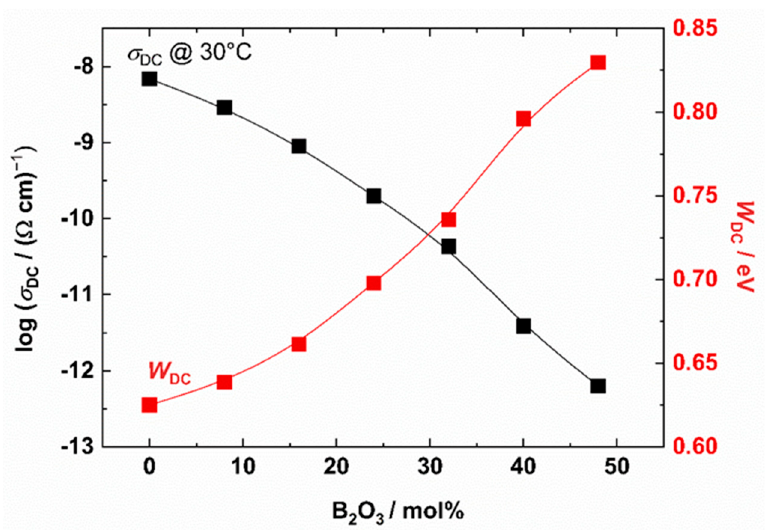
Figure 9. DC conductivity at 30 °C (black line) and activation energy for DC conductivity (red line) as a function of B 2 O 3 content for (100 − x)[0.4P 2 O 5 –0.2Nb 2 O 5 –0.4P 2 O 5 ]-xB 2 O 3 , 0 ≤ x ≤ 48 mol%, glasses. The lines are drawn as guides for the eye. Table 3. The number density of sodium ions, N, DC conductivity, 𝜎 (cid:3005)(cid:3004) , determined as a plateau value in the conductivity isotherms, activation energy, W DC , for (100 − x)[0.4Na 2 O-0.2Nb 2 O 5 -